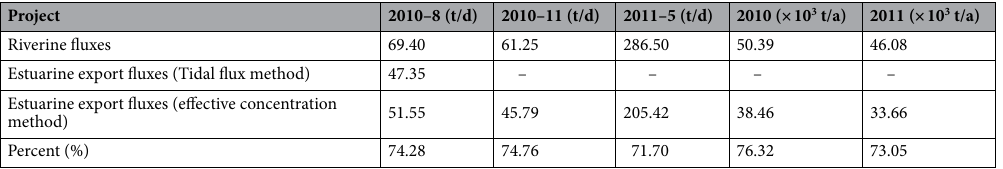
Table 5. Estimated TOC fluxes in